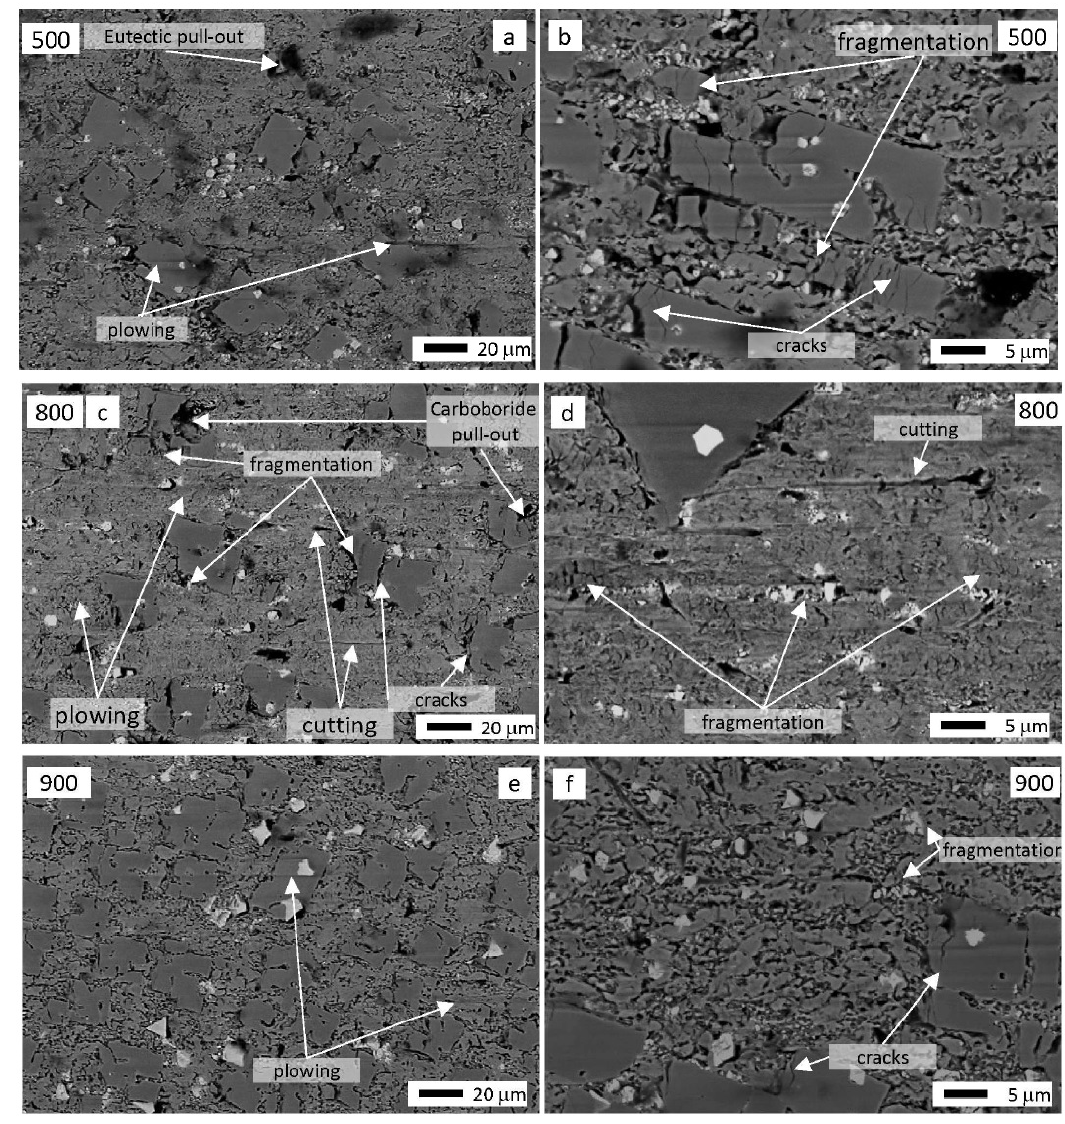
Figure 11. BSE mode images of the worn surface at a,b) 500, c,d) 800 and e,f)